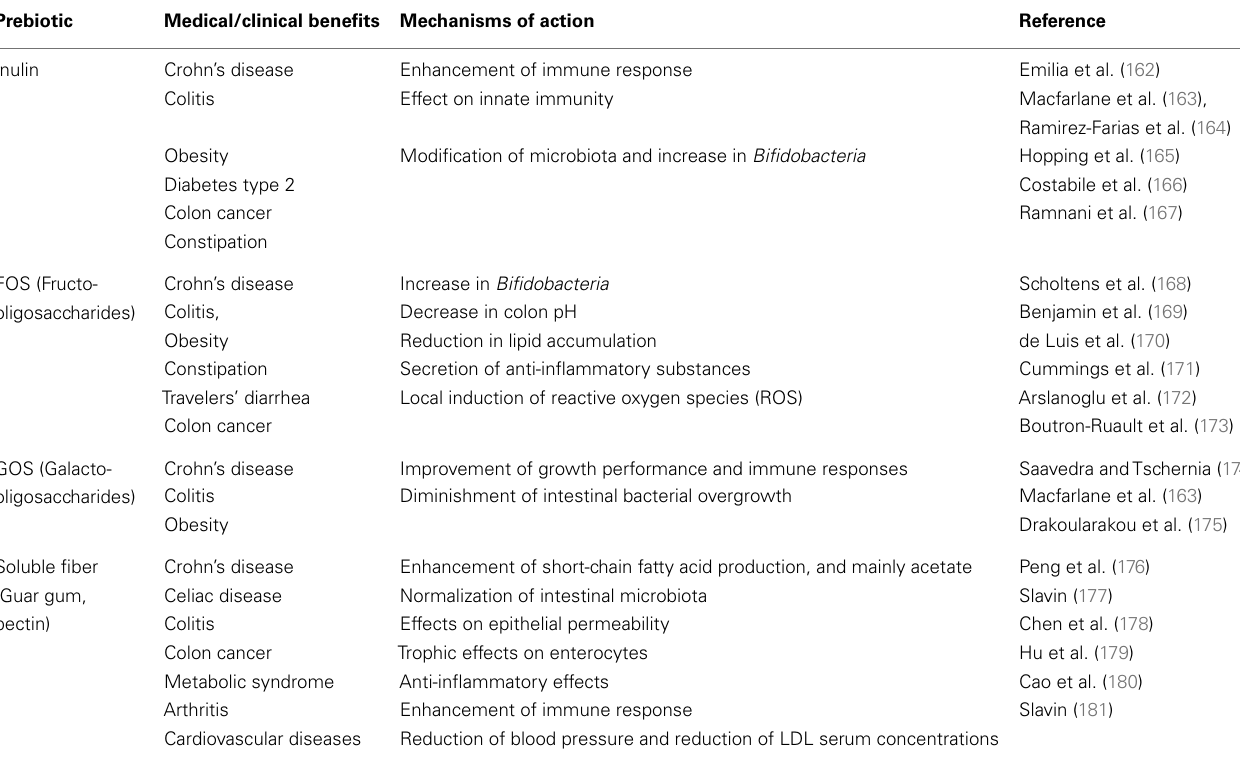
Table 4 | Main benefits of the major prebiotics and potential mechanisms of